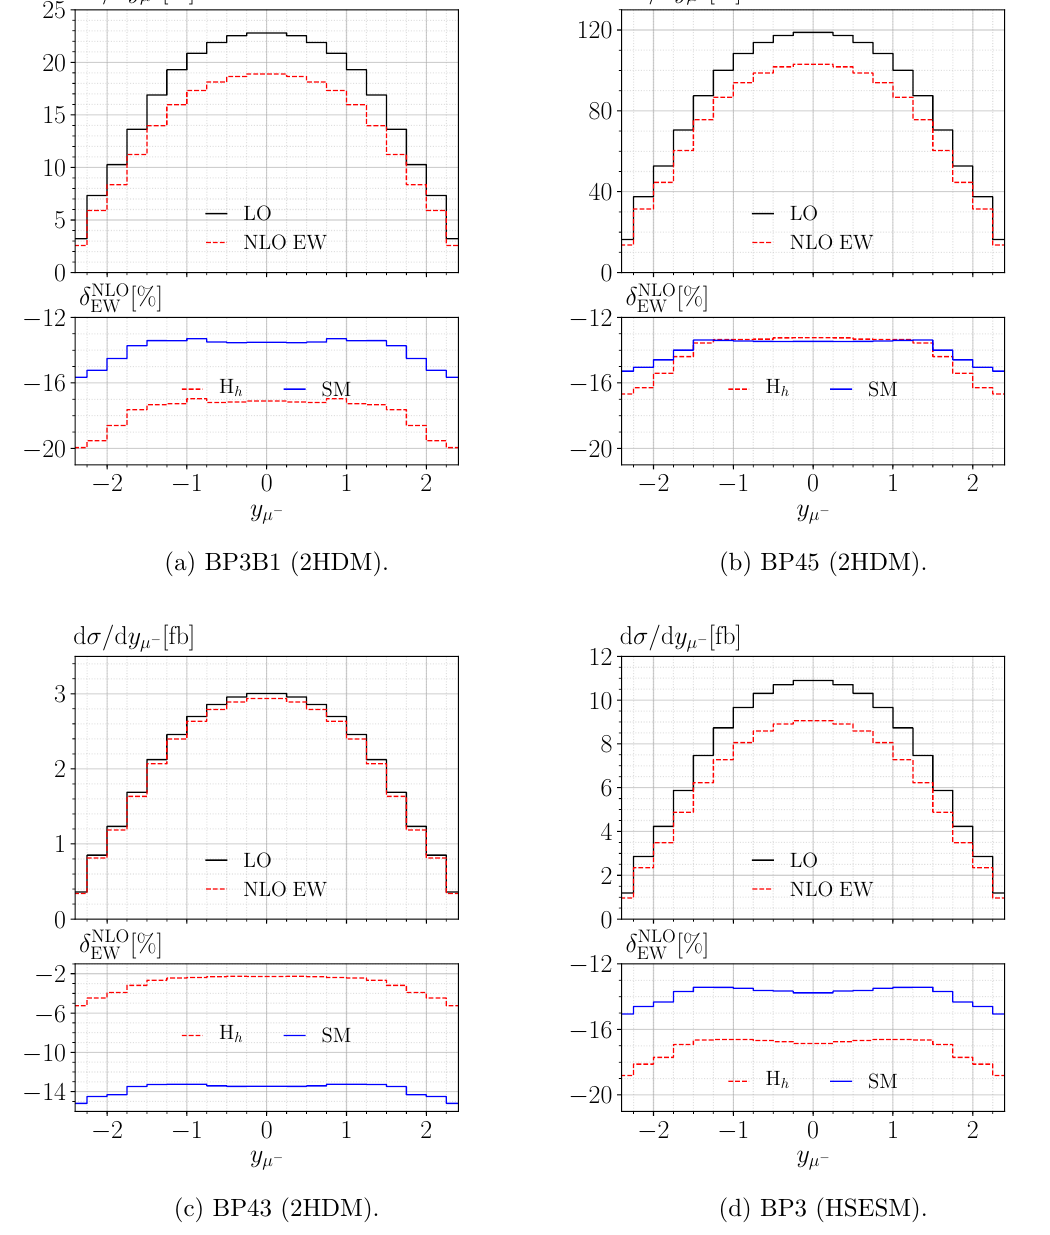
Figure 7. Distributions in the rapidity of the muon y strahlung for the benchmark points BP3B1 in (a), BP45 in (b) and BP43 in (c) in the 2HDM, and BP3 in (d) in the